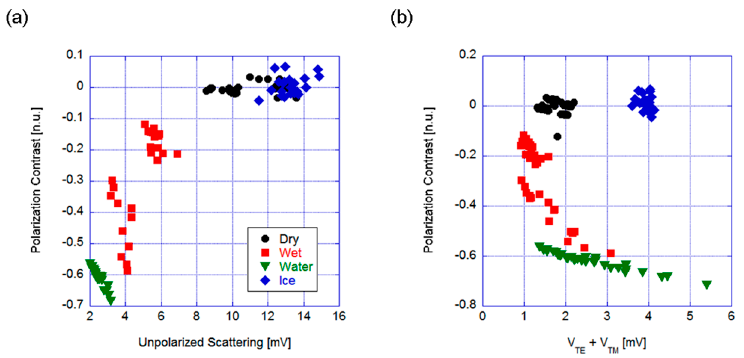
Figure 3. Mirror-like configuration. Polarization contrast versus ( a ) the total scattering and ( b ) the sum of the two orthogonal polarized components (V TE and V TM , the voltage corresponding to horizontal and vertical polarization, respectively).